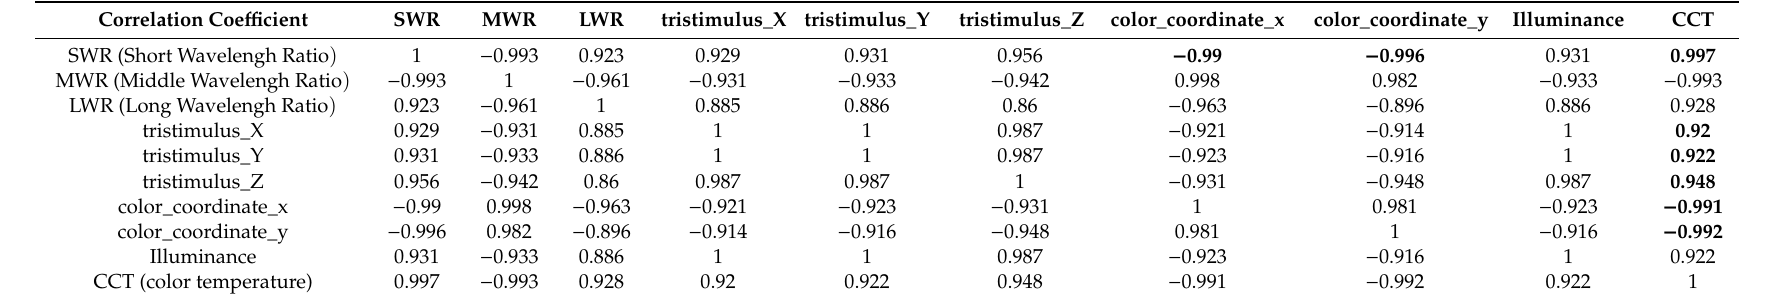
Table 2. Results of analyzing correlation coe ffi cients among certain factors of natural light: clear